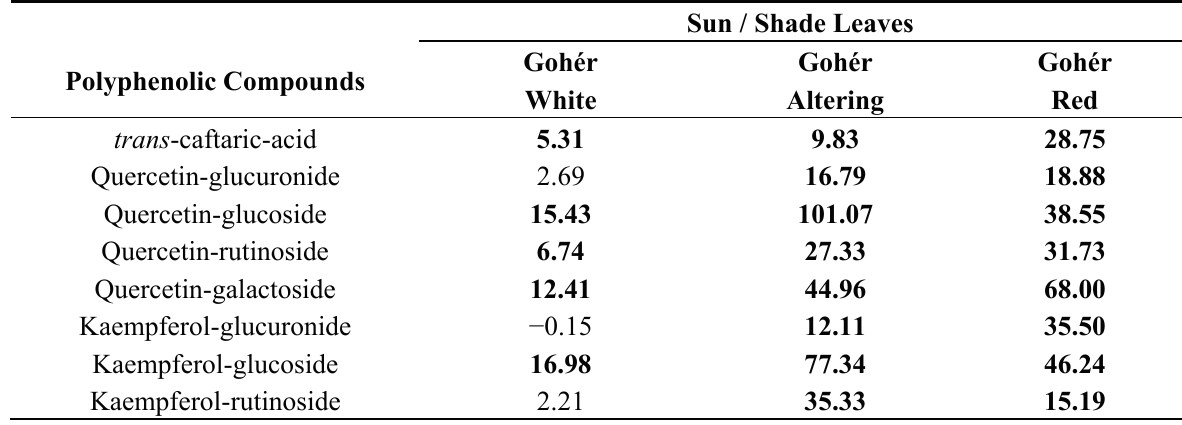
Table A2. Actual t -values corresponding to the polyphenolic composition of sun and half shade leaves of Gohér varieties. Significant differences at p ˂ 0.05 indicated in